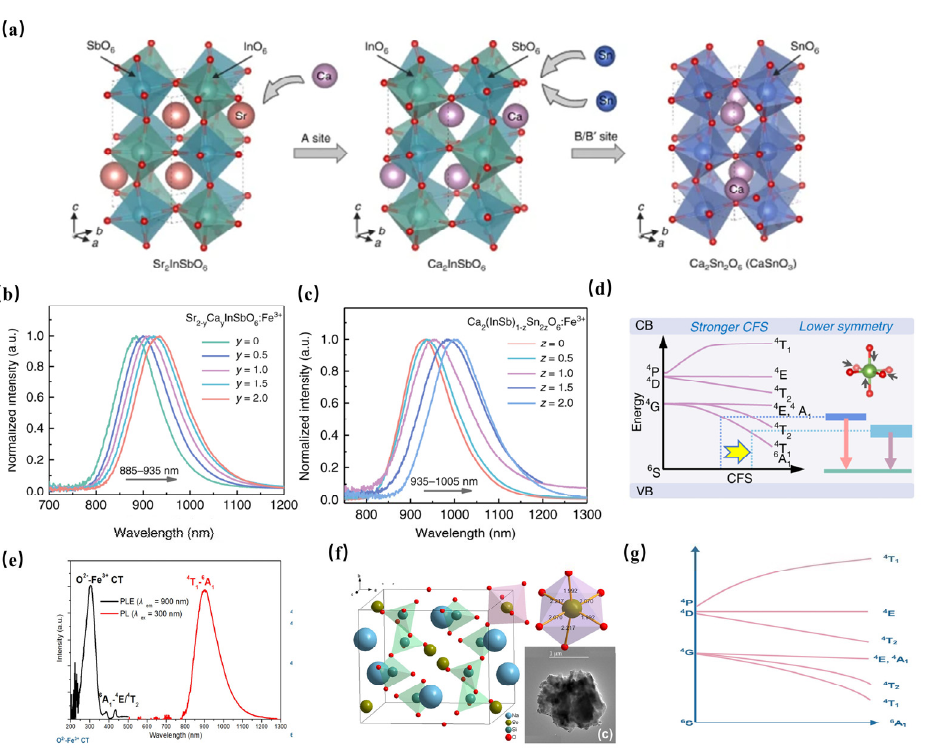
Figure 12. ( a ) Structure characterizations of Sr 2 − y Ca y (InSb) 1 − z Sn 2 z O 6 :Fe 3+ (Ex = 340 nm). ( b ) Normalized PL spectra of Sr 2 − y Ca y InSbO 6 :Fe 3+ ( y = 0–2) (Ex = 340 nm). ( c ) Normalized PL spectra of Ca 2 (InSb) 1 − z Sn 2 z O 6 :Fe 3+ ( z = 0–1). ( d ) Schematic diagram of the overall PL tuning mechanism [63]. ( e )